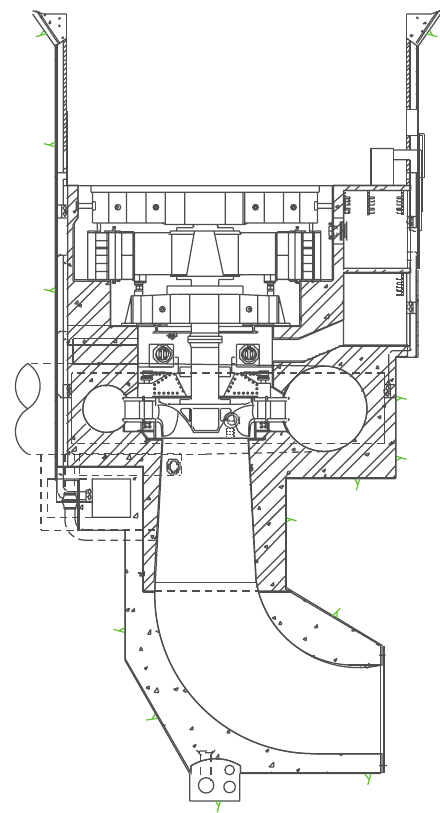
Figure 2: Cutaway view of the main structure of hydropower.